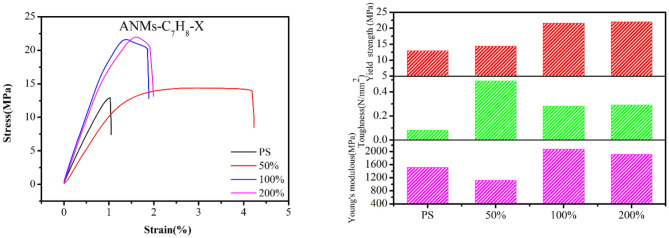
Mechanical testing diagram and results of pure PS and the ANMs-C7H8-X/PS.